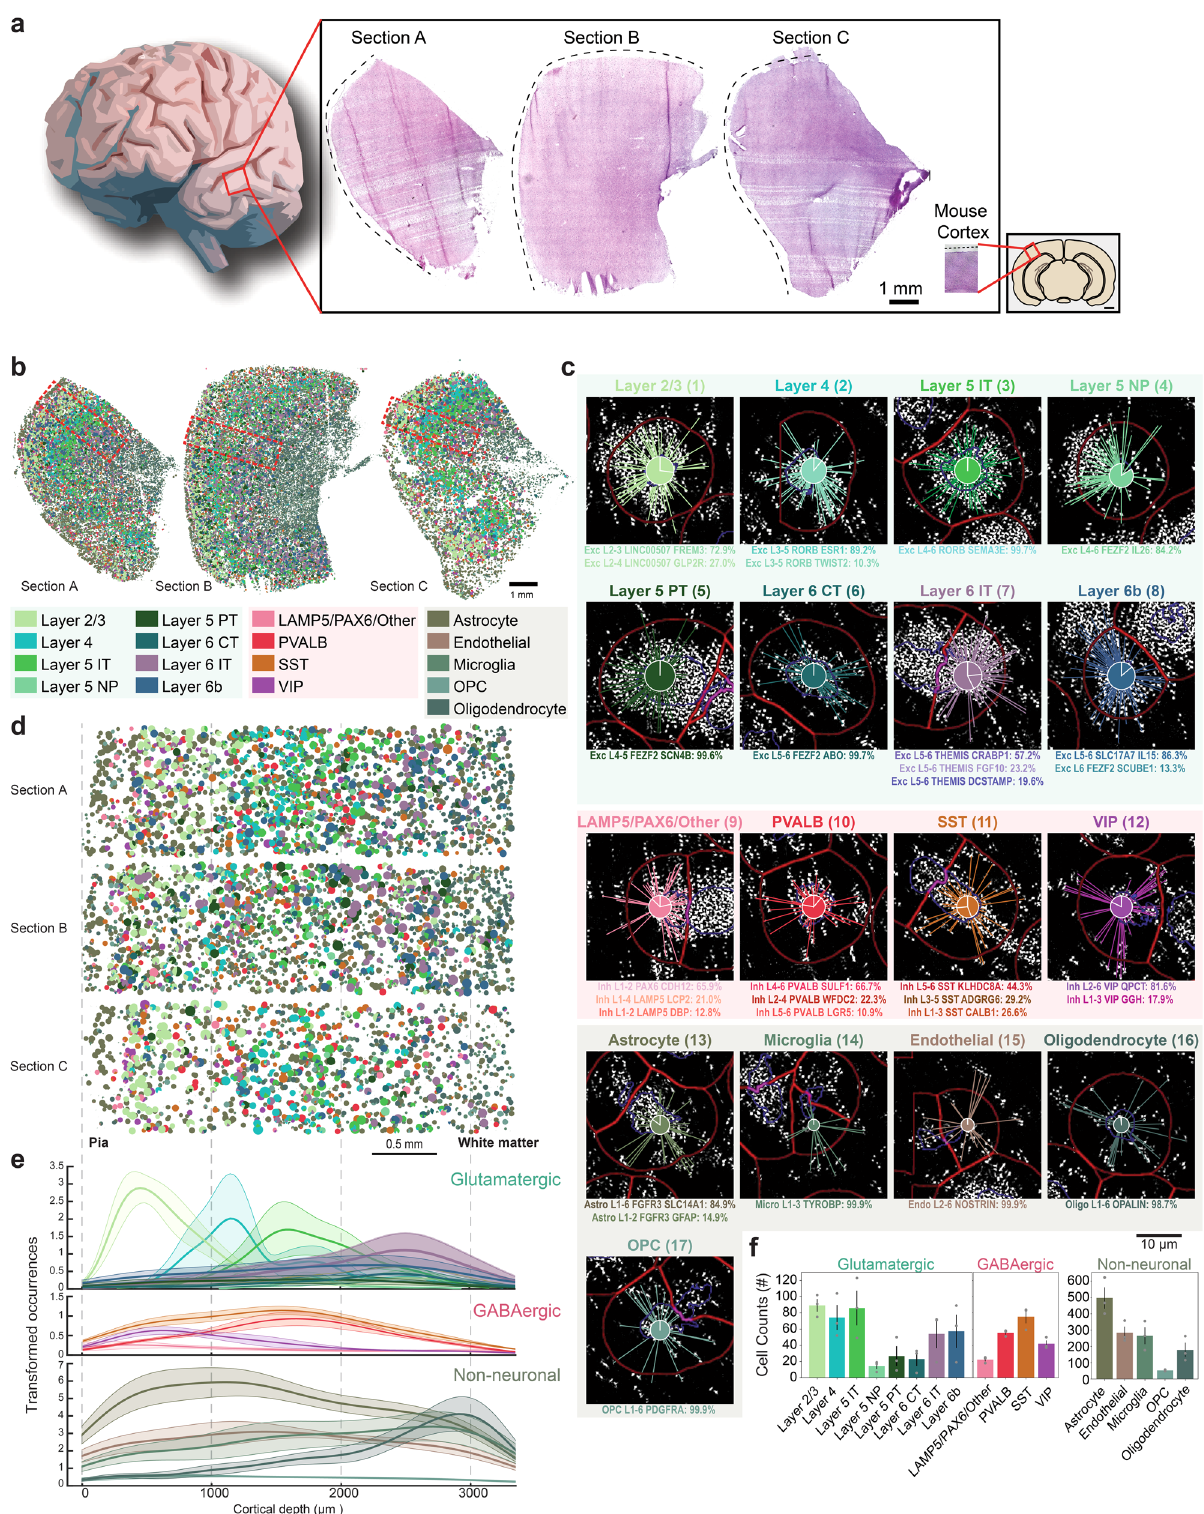
the snRNA-seq (Supplementary Figs. 9f and 10c) and could re fl ect the difference in a sampling of snRNA-seq data, that contains 94% neuronal cells vs. 6% non-neuronal cells. Azevedo et al. 1 suggest 20% neuronal vs. 80% non-neuronal cell types in the cerebral cortex. pciSeq results show comparable quantities for neuronal (23%) vs. non-neuronal (77%) cells and also a sample-to-sample correlation of non-neuronal cells in pciSeq data was high